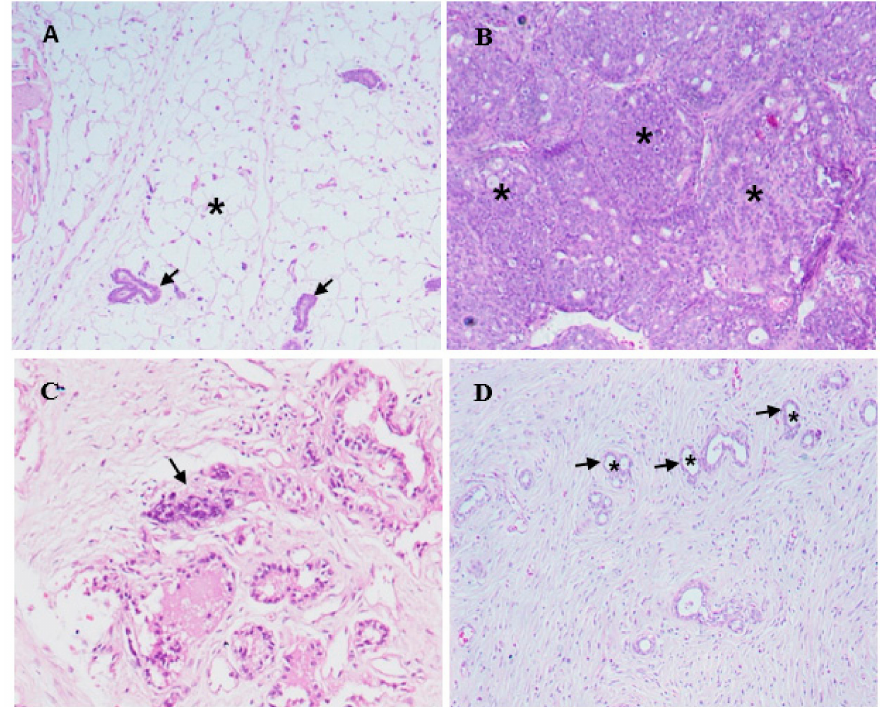
Figure 8. Light micrographs showing mammary gland tissues in control rats, DMBA-injected rats, and DMBA-injected rats treated with RSF EtOAc extract ( A ) Structure of mammary gland tissue in a control rat. Arrows indicate ducts and epithelial lining cells. Adipose tissue (*) surrounds the ducts ( B ) Mammary gland tissue of DMBA-injected rat showing markedly proliferating neoplastic ductal epithelial cells (*) obliterating the ductal lumina ( C ) Area of necrosis (arrow) in the mammary gland tissue of